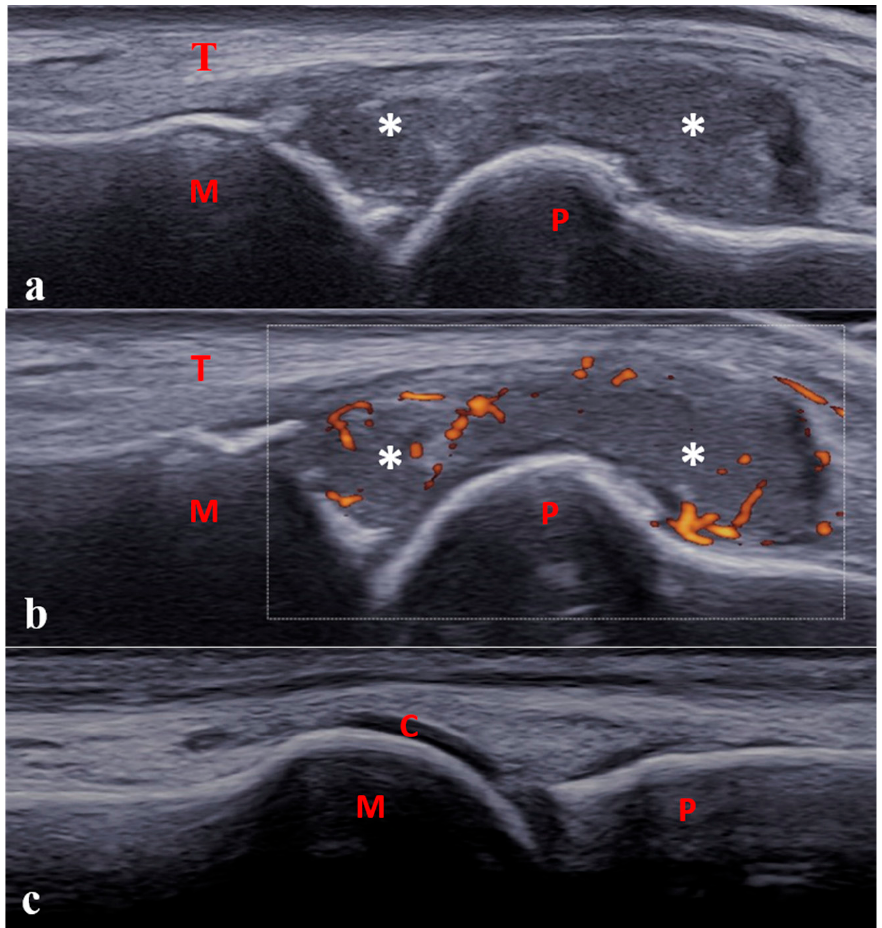
Figure 4. Longitudinal dorsal scan of one metatarsophalangeal joint in a 13-year-old boy with enthesitis-related arthritis. ( a , b ) Severe synovitis (B-mode grade 3) with moderate power Doppler activity (<30% of the synovial hypertrophy surface, grade 2). ( c ) Physiological aspect of the contra- lateral joint. C: cartilage; M: metatarsal; P: proximal phalanx; T: tendon; * Synovitis .